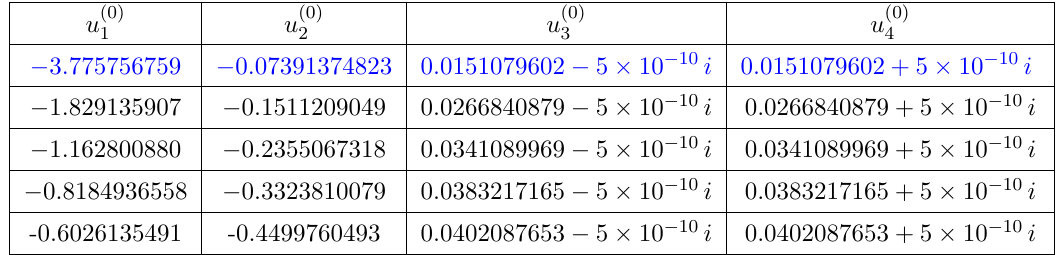
Table 9 . Momentum carrying roots at leading order in g 2 : almost singular solutions for L = 24 and so (6) root numbers 10 digits of precision. To see their deviation from the singular position i and in particular 10 (cid:0) 45 for the solution highlighted in blue.